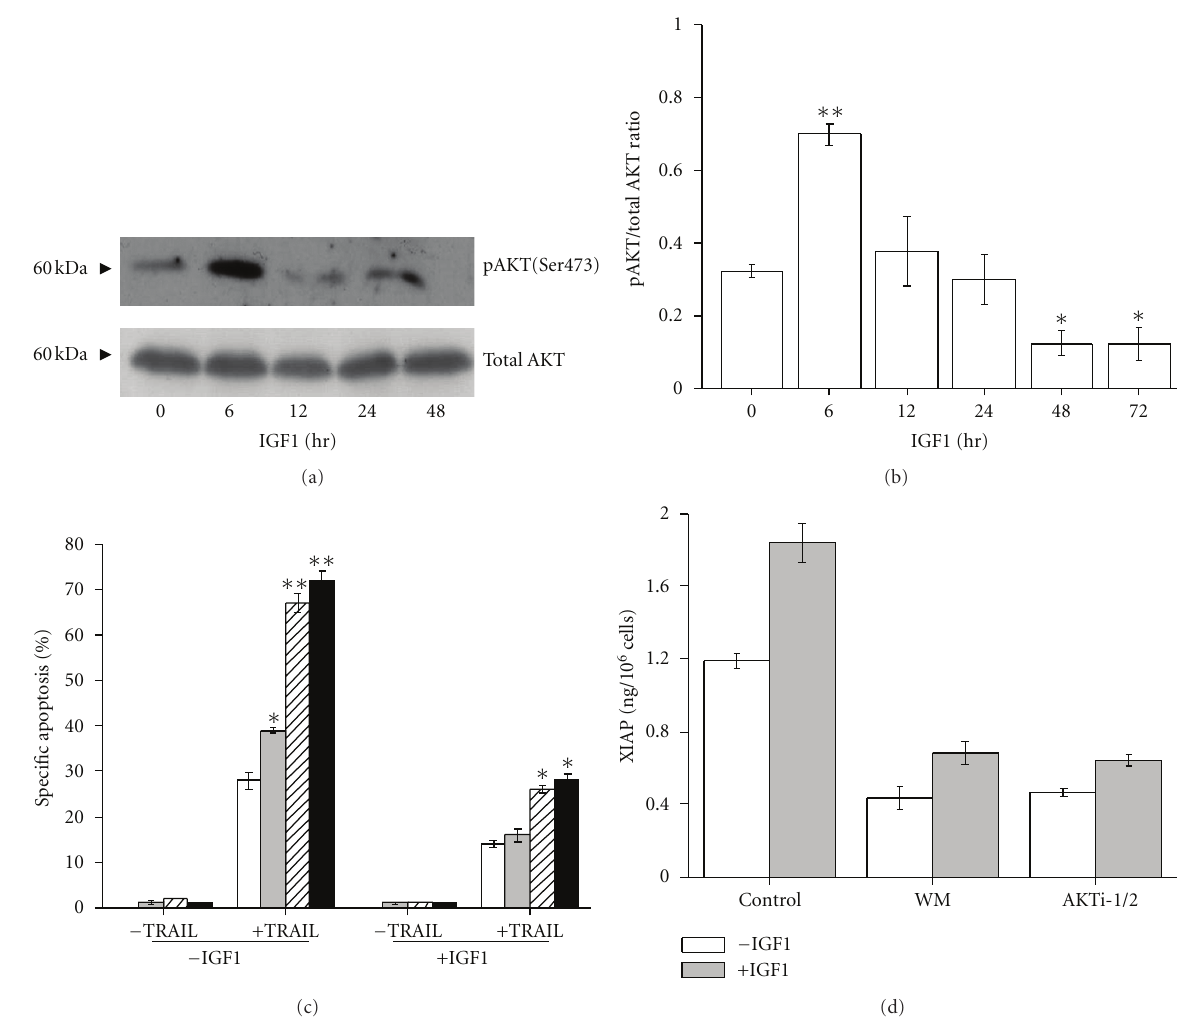
Figure 5: Activation of AKT is associated with increased XIAP protein expression and Apo2L/TRAIL resistance. (a) Western blot assays of VH-64 cell lysates with antibodies to phosphorylated AKT and total AKT. Cells were treated for the indicated times with IGF1 (100ng/mL). The antitotal AKT blot serves as a loading control. Representative nonstripped blots separately probed with the di ff erent antibodies are shown. (b) Ratio of phosphorylated AKT to total AKT determined by ELISA in cells treated for the indicated times with IGF1 (100ng/mL). (c) Percentage-specific apoptosis in VH-64 cells treated without (white columns) and with 50nM (grey columns), 200 nM (striped columns), and 500 nM (black columns) wortmannin in the absence and presence of IGF1 (50ng/mL; 24 hours), followed by incubation without and with Apo2L/TRAIL (TRAIL; 50ng/mL; 8 hours). (d) EIA analysis of XIAP in cells treated with wortmannin (WM; 500 nM), AKTi-1/2 (2 μ M), and serum-free medium alone (Control), followed by incubation in the absence and presence of IGF1 (100 ng/mL; 24 hours). Asterisks: ∗ P < 0 . 05, ∗∗ P < 0 . 02; error bars: mean ± SD of triplicate determinations from 3 independent